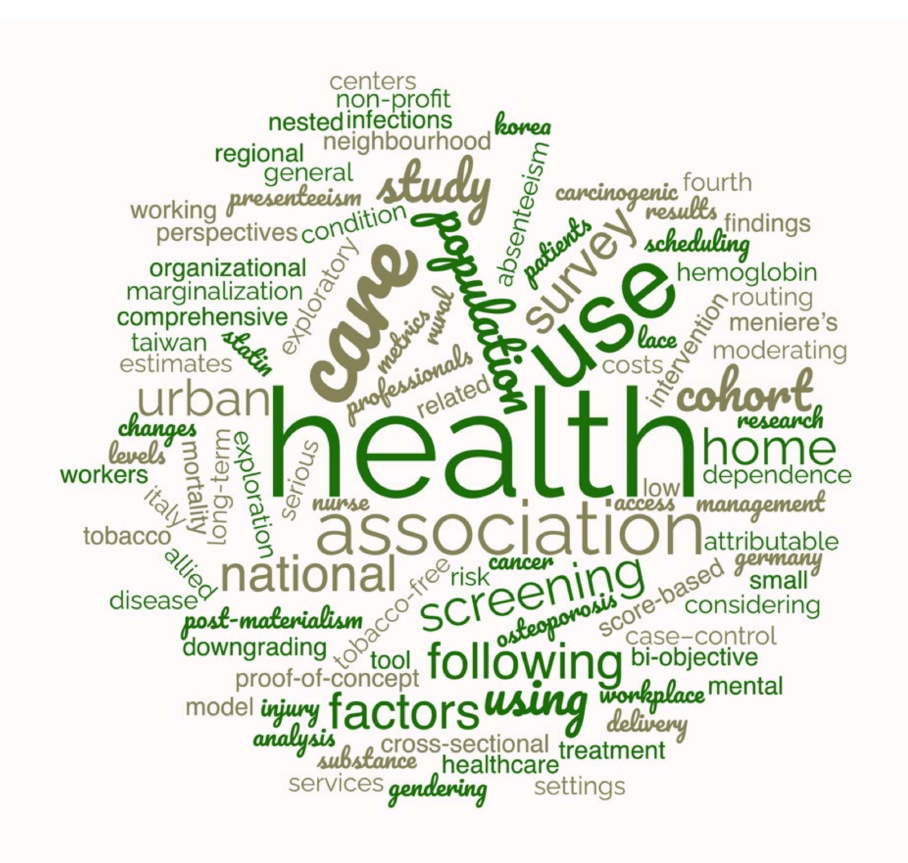
Figure 1. Word cloud based on the titles of manuscripts published in the Special Issue, “Advances in Population-Based Healthcare Research: From Measures to